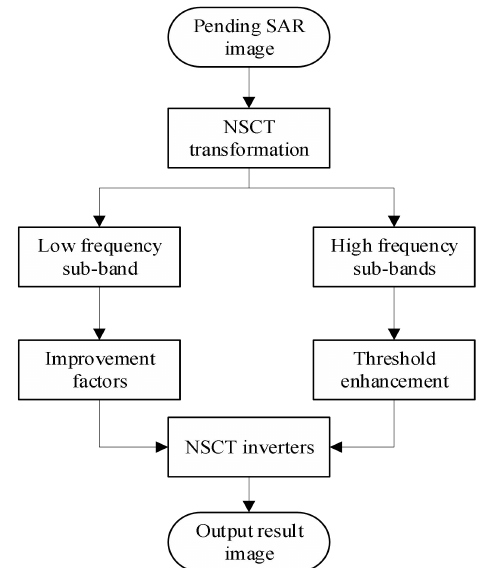
Figure 1. Flow chart of NSCT-based SAR image